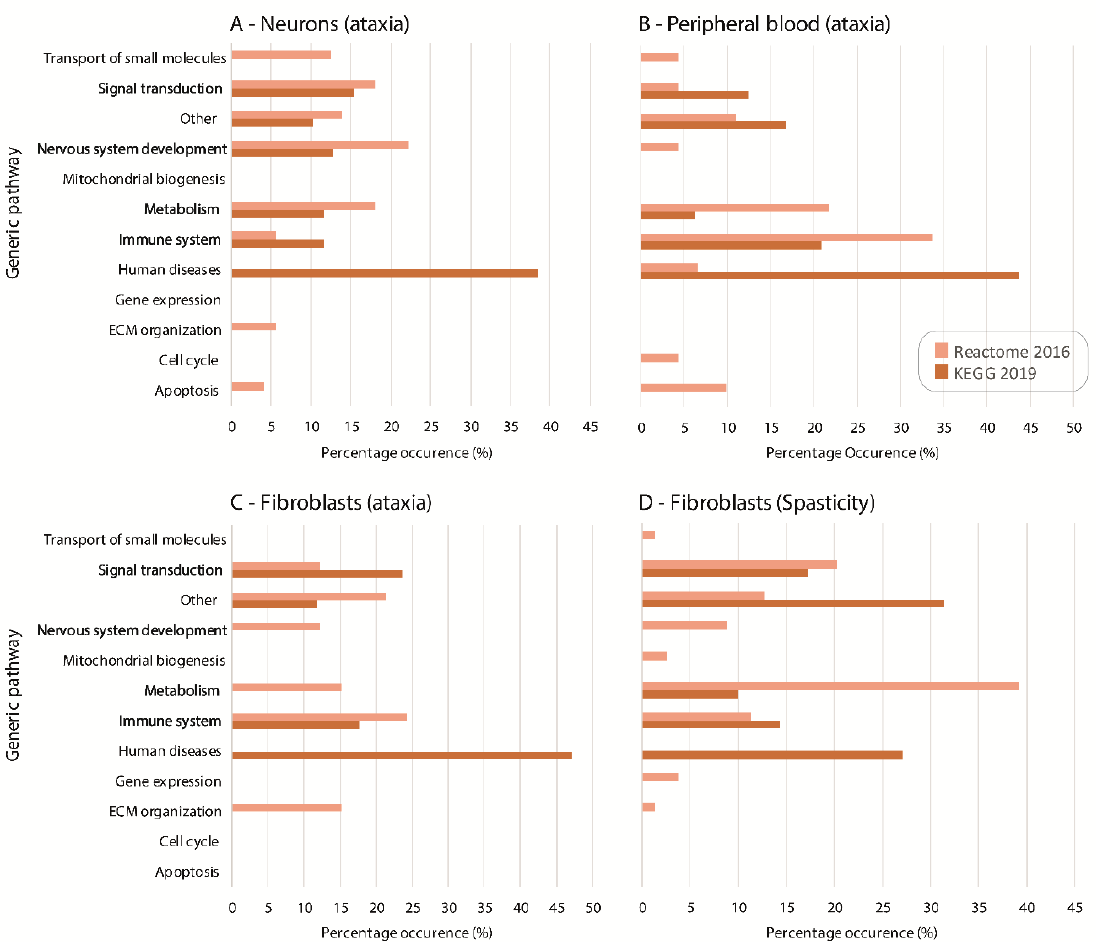
Figure 1. KEGG 2019 and Reactome 2016 enrichment analysis was performed on the lists of DEGs resulting from Limma analysis. The generic pathway categories in which the pathways belong based on KEGG 2019 and Reactome 2016 hierarchical clustering are presented for ( A ) the neuronal “ataxia” datasets and further supported in ( B ) peripheral blood “ataxia”, ( C ) fibroblast “ataxia”, and ( D ) fibroblast “spasticity” datasets. The KEGG 2019 results are shown in dark orange colored bars and the Reactome 2016 results in light orange. The common generic pathway categories across different tissues are shown in bold. Percentage occurrence (%) represents the number of pathways that belong to each general pathway category over the total number of pathways ( p -value < 0.05) given by EnrichR analysis.